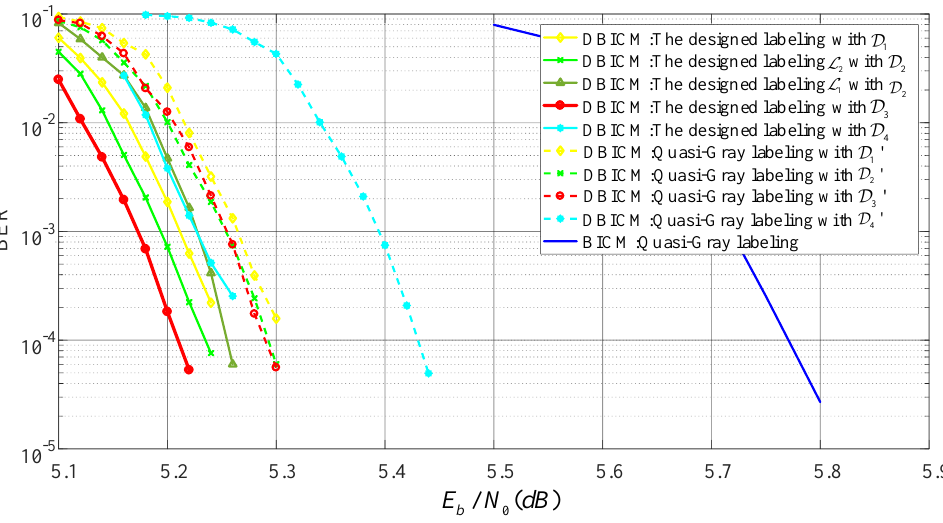
Figure 8. BER performance with code rate